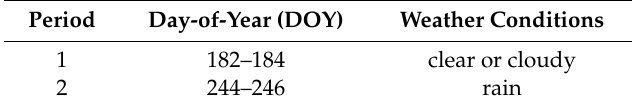
Table 1. Two periods and their day-of-years (DOY)s and weather conditions.